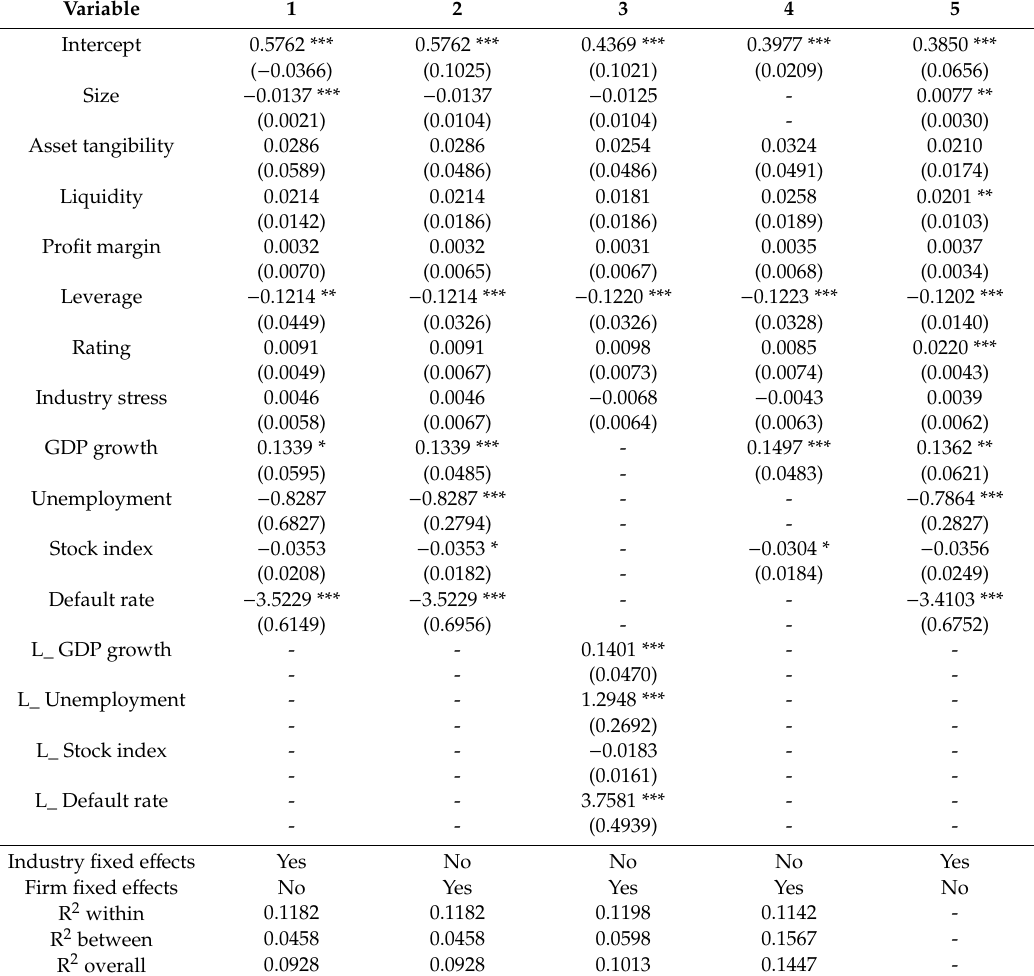
Table 7. Regression results for the level of market-implied recovery rates. Robust standard errors are reported in parentheses. Variables preceded by “L_” are lagged by one quarter. Statistical significance at the 10%, 5%, and 1% level is indicated by superscript *, ** and ***,